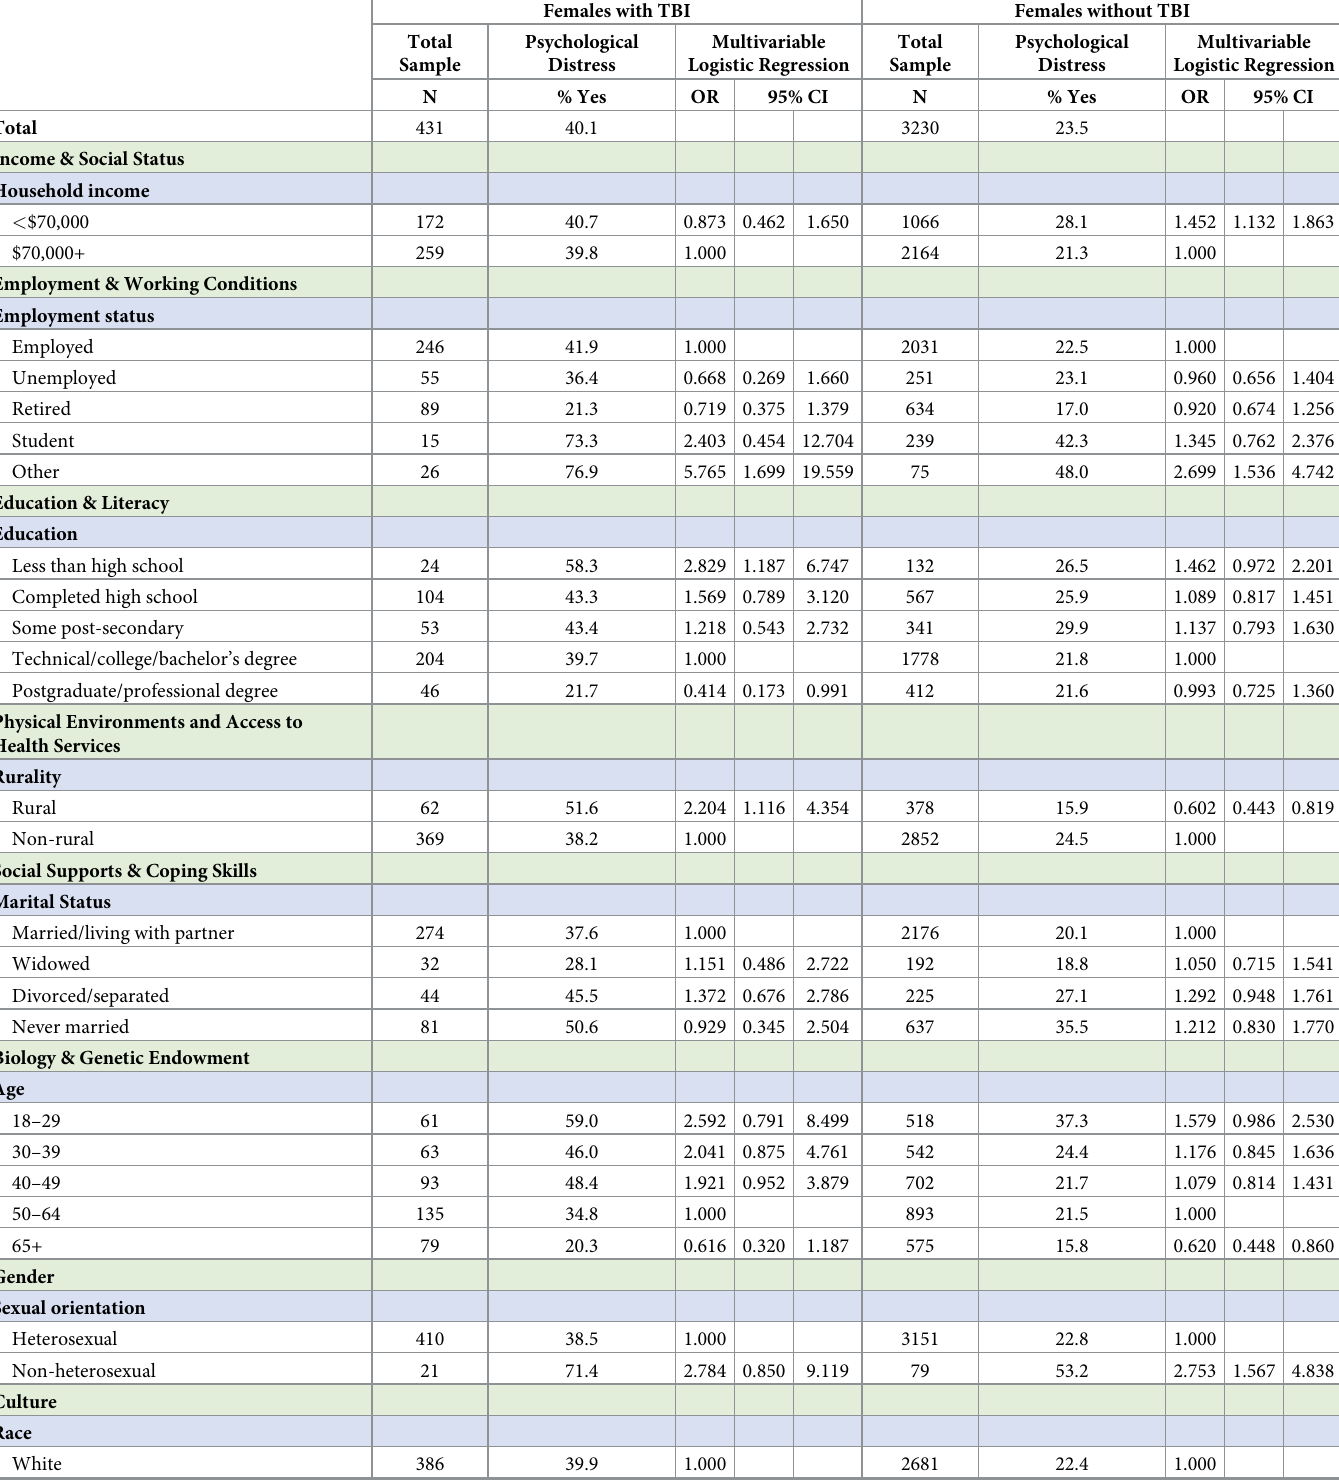
Table 3. Prevalence of psychological distress and multivariable logistic regression analyses of SDoH and psychological distress among females with and without